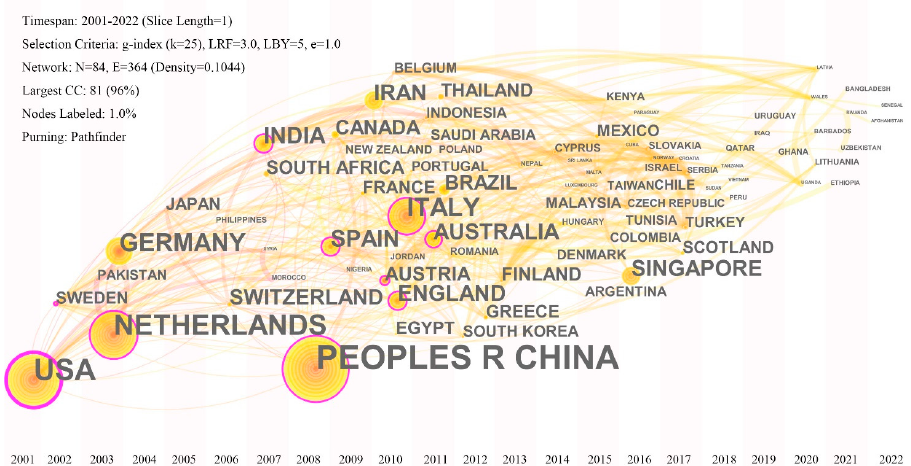
Figure 3. Time-zone view of country collaboration network.